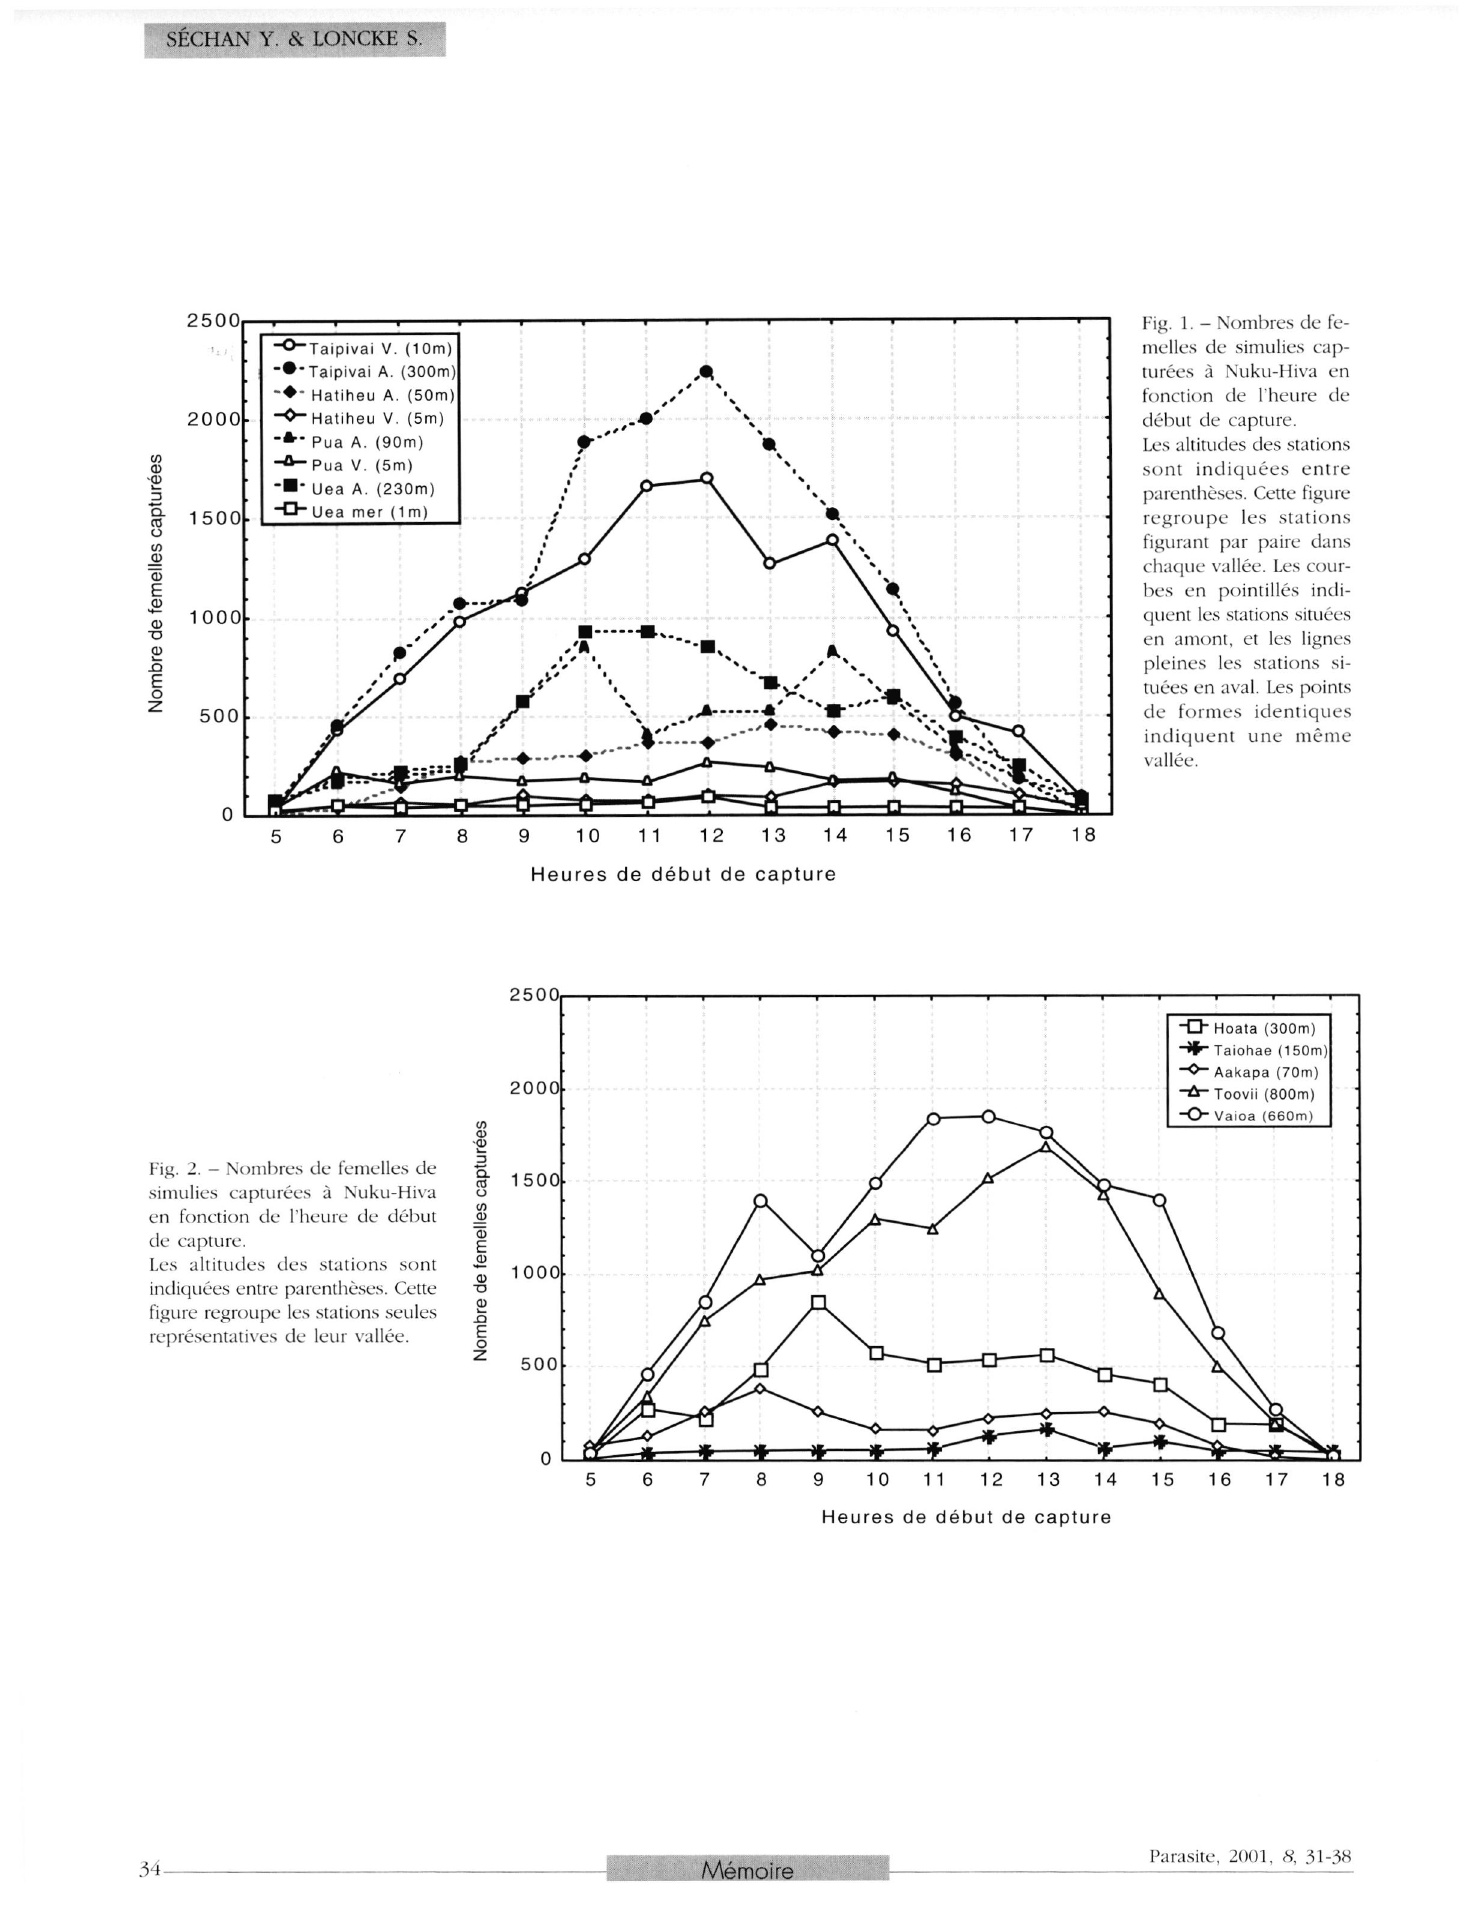
Fig. 1. - Nombres de fe melles de simulies cap turées à Kuku-Hiva en fonction de l'heure de début de capture. Les altitudes des stations